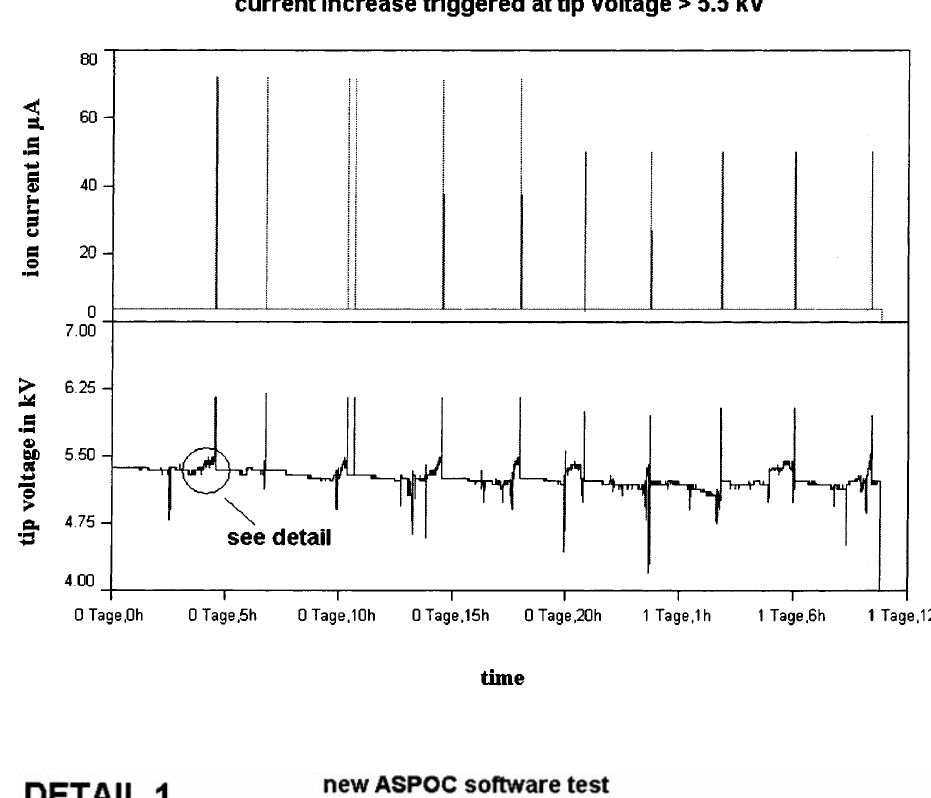
Fig. 4. Test of software for tip cleaning. Upper panel : ion current pulses are triggered by ( lower panel ) voltage increases above